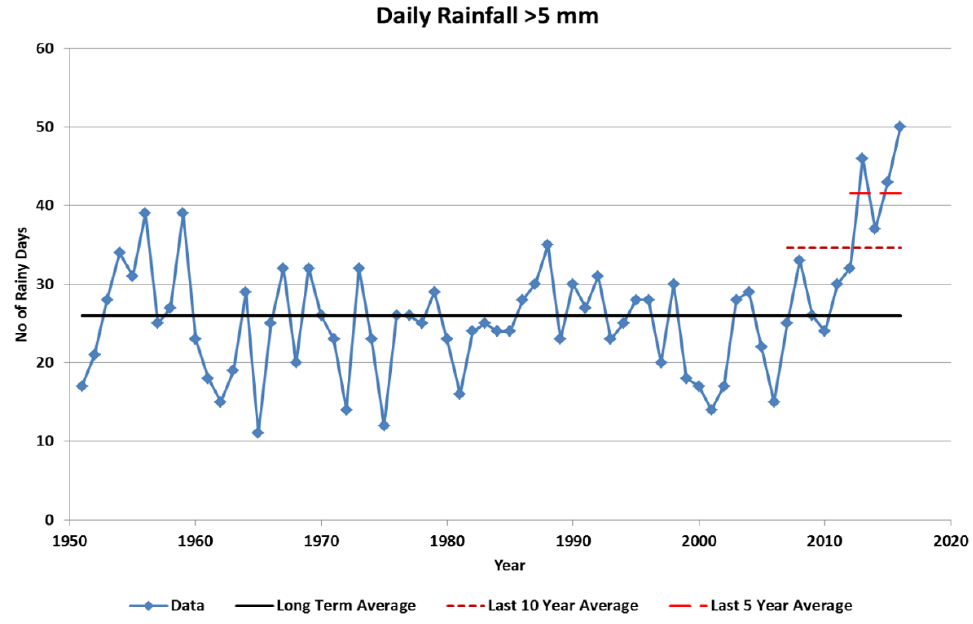
Figure 5. Annual number of rainy days in Beijing (1951–2016) GHCND: CHM00054511 [36]. Increasing urban spatial dimensions and the number of storms is forcing consideration of urban drainage systems to transition to the future. City engineers have to expand the spectrum from “too little water” (shortage of water supply) to “too much water” (flooding). When adding in the complications associated with megacities as a result of both their enormous water demands and the anthropogenic water quality